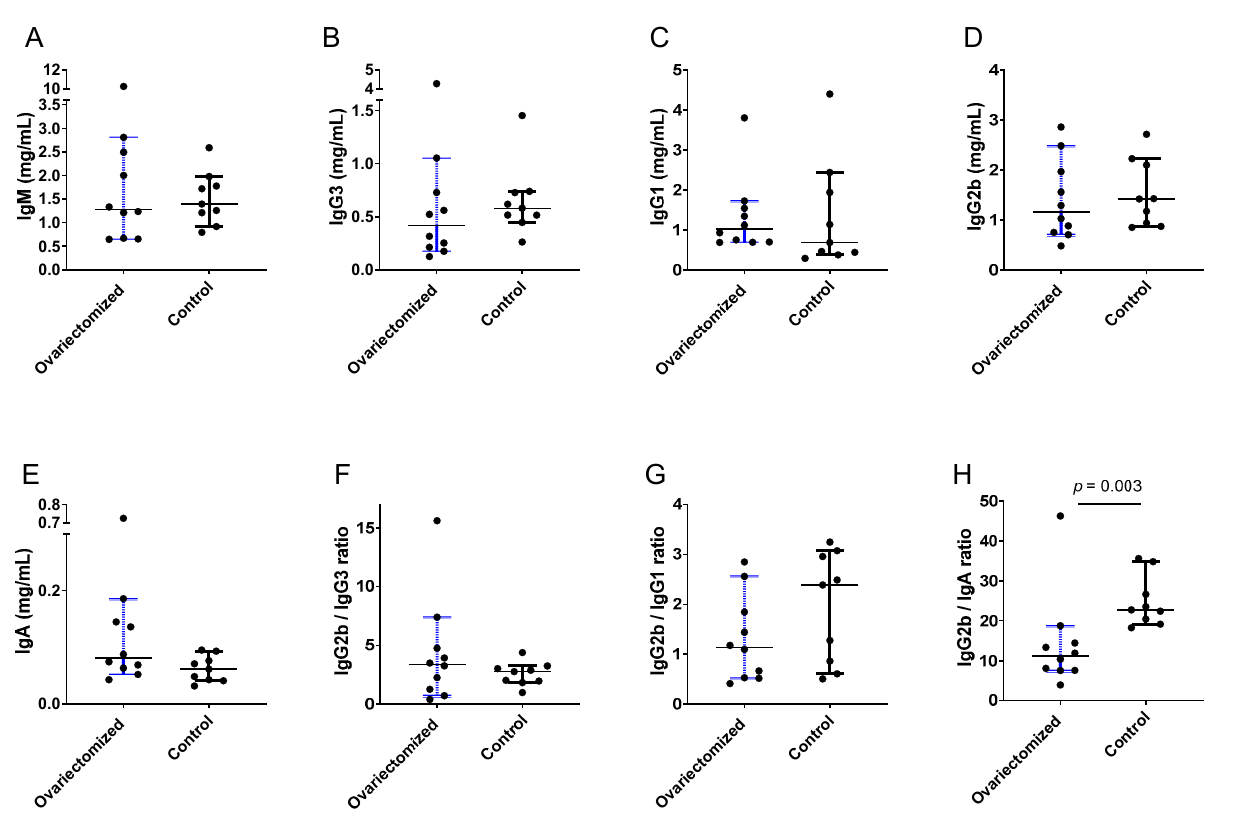
Figure 2. Immunoglobulin isotype patterns in ovariectomized and control mice. Each mouse is represented by a different symbol. Group medians are shown with 95% CI. p values from Mann–Whitney tests are shown when p ≤ 0.1. Individual isotypes ( A – E ) and ratios ( F – H ) are shown. Table 2. Higher preference for IgG2b in unmanipulated (control) compared to ovariectomized female mice.